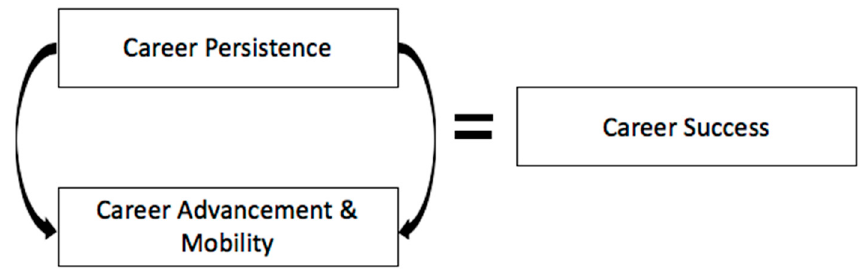
Figure 1. Components of women’s professional success. Source: Salvaj and Kuschel (forthcoming).